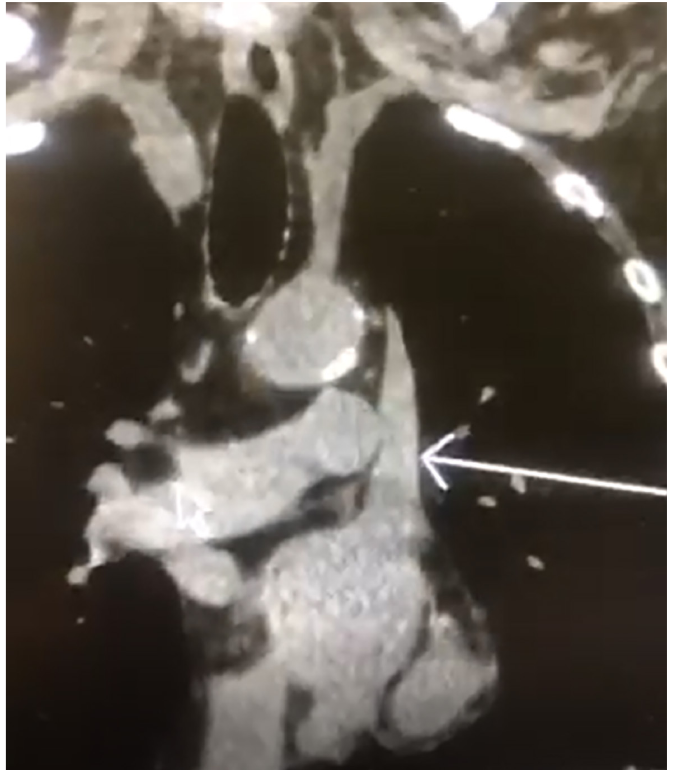
Image 2. Computed tomography of the chest obtained at prior hospitalization demonstrates the presence of a persistent left- sided superior vena cava (arrow), as well as the complete absence of an accompanying right-sided superior vena